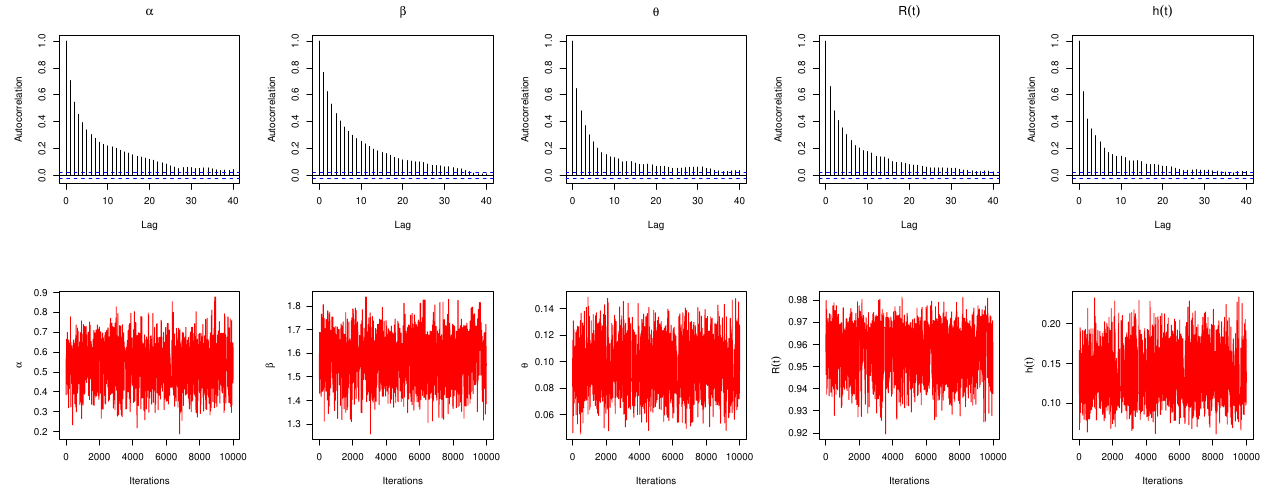
Figure 2. Autocorrelation ( top-panel ) and Trace ( bottom-panel ) plots for MCMC draws of α , β , λ , R ( t ) and h ( t )